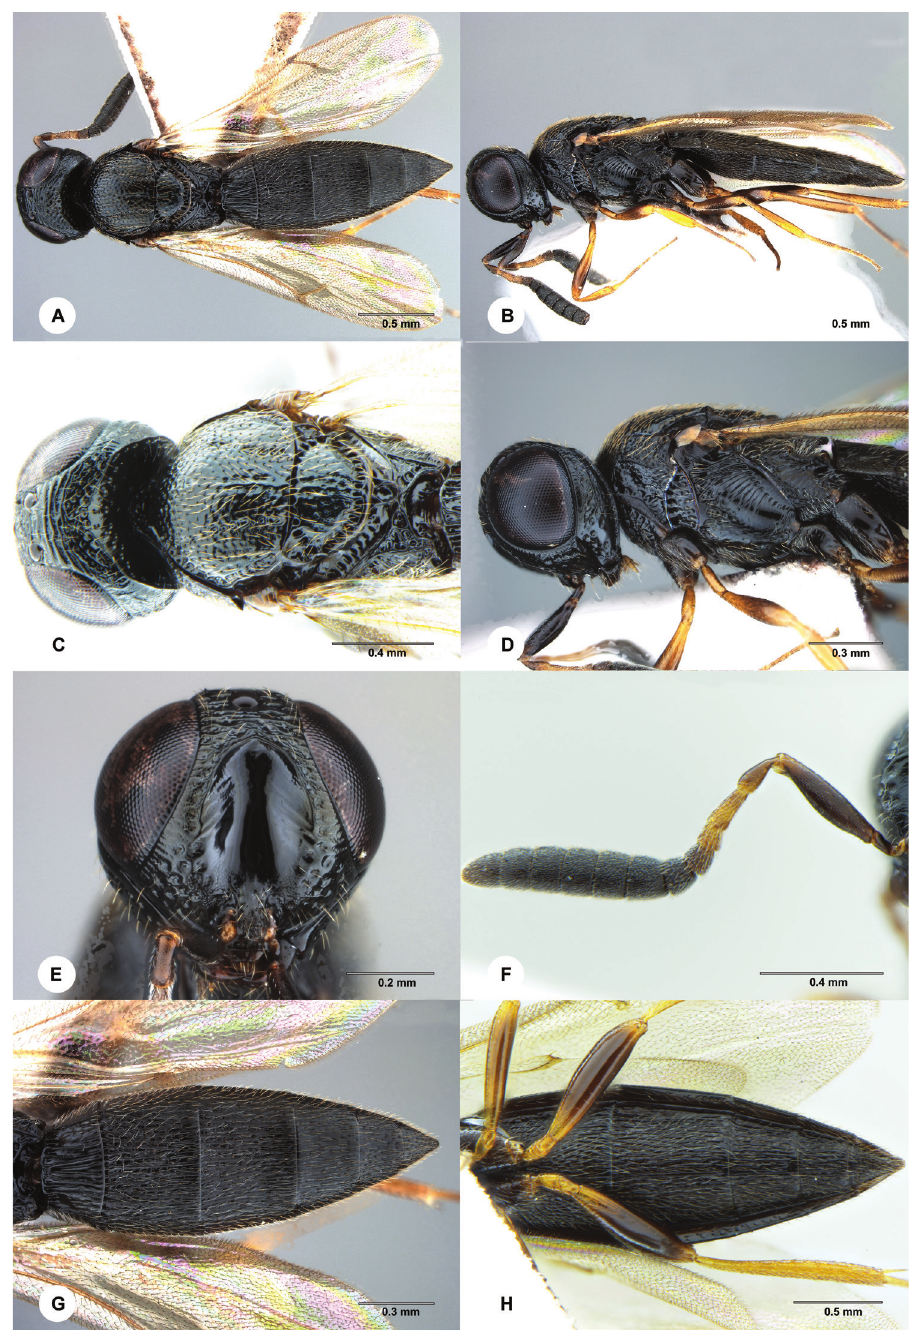
Figure 3. Oxyscelio apheles Mo & Chen, sp. nov., holotype, female (SCAU 3049046) A dorsal habitus B lateral habitus C head and mesosoma, dorsal view D head and mesosoma, lateral view E head, anterior view F Antenna G metasoma, dorsal view H metasoma, ventral